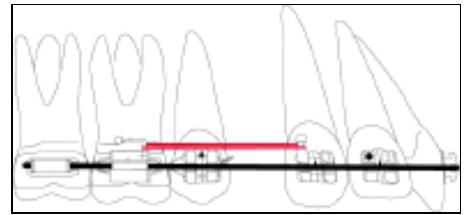
Figure (4): Using of elastic band for canine